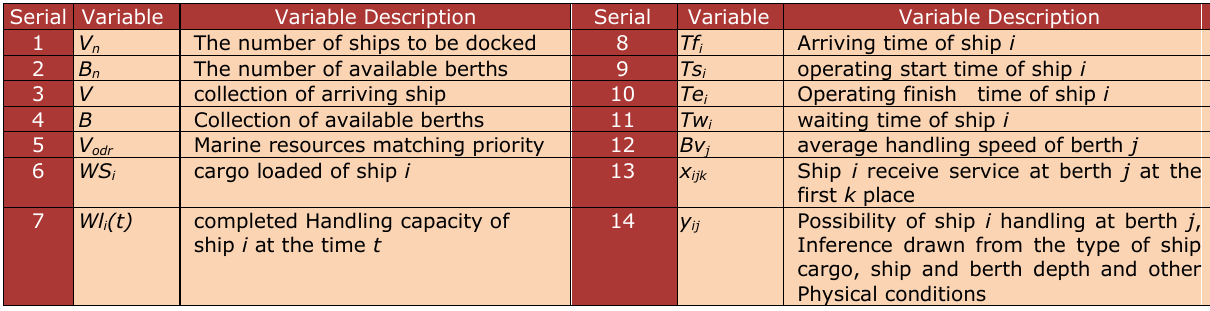
Table 1. Parameter list of dynamic berth assignment